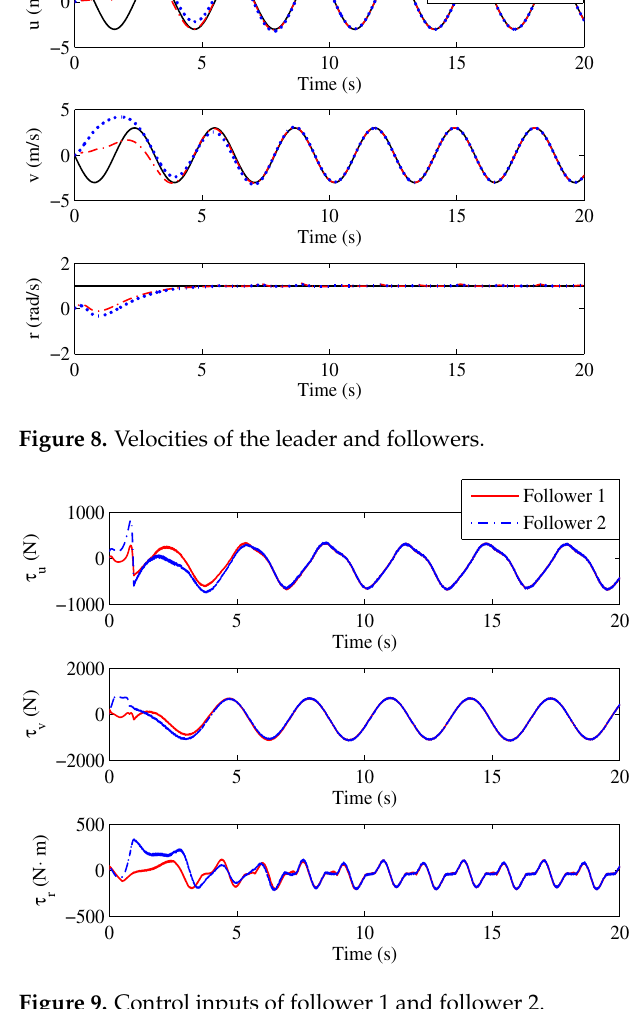
Figure 9. Control inputs of follower 1 and follower 2.